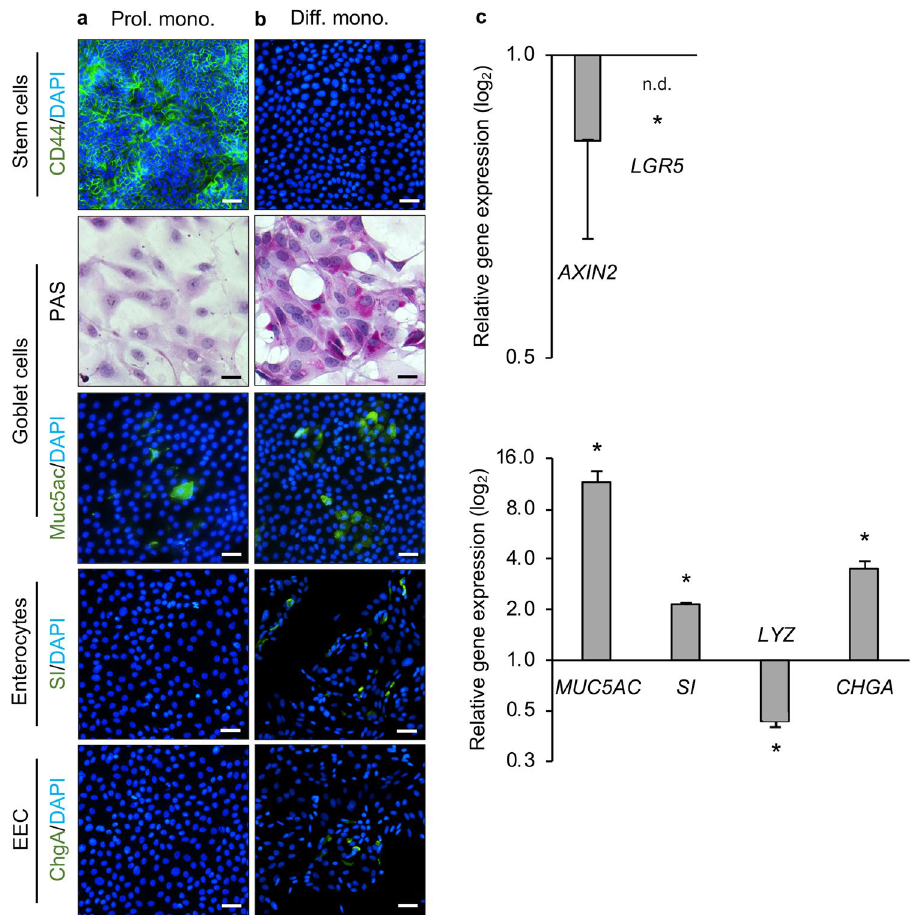
Figure 4. Identification of different cell types in rabbit duodenal monolayer cultures. ( a ) Proliferating (Prol.) and ( b ) differentiated monolayer (Diff. mono.) cultures were immunostained for CD44 (green), PAS (magenta), Muc5ac (green), SI (green) and ChgA (green); nuclei were counterstained with DAPI (blue). Scale bars = 200 μm except for PAS-stained images where scale bar = 50 μm. ( c ) Expression of stem cell-associated ( AXIN2 and LGR5 ) and intestinal epithelial maturation-associated genes ( MUC5ac , SI , CHGA and LYZ ) in differentiated rabbit duodenal monolayer cultures. Data are presented as fold change (2 −ΔΔCt ) in gene expression from proliferating monolayer cultures, calculated from three individual cell culture wells with three technical RT-qPCR replicates each. LGR5 expression was not detected (n.d.) in differentiated monolayer cultures. Error bars represent standard errors of the mean. Student’s t-test was performed to assess the statistical significance; only statistically significant differences are shown (* p < 0.05). All experiments were conducted in spheroid- derived monolayers from a single laboratory